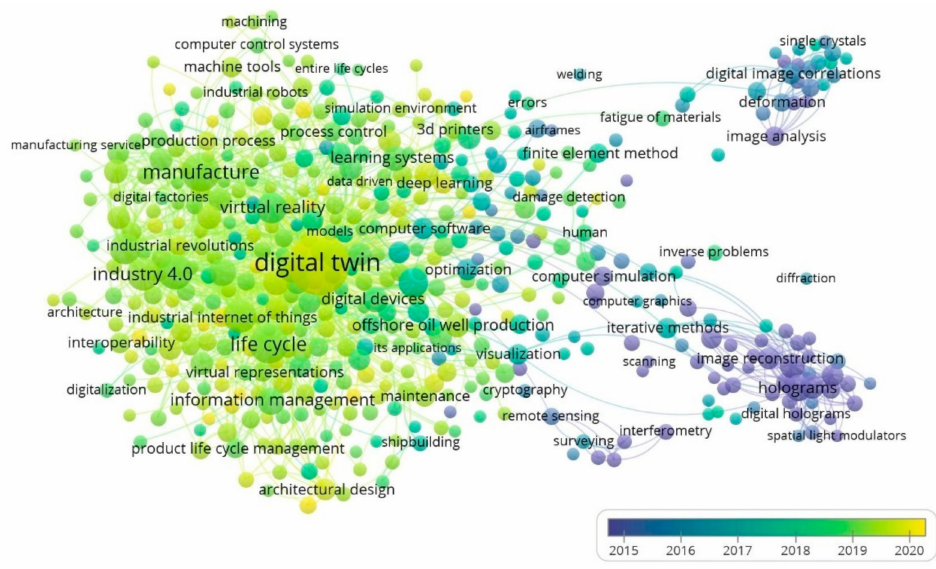
Figure 8. Overlay visualization of the DT research field. The keywords were grouped into clusters, represented by different colors. In particular, the keywords were clustered into seven groups, and each keyword was assigned to only one cluster. As shown by the network visualization (Figure 7), the DT research field is primarily composed of seven clusters of connected topics: Industry 4.0 and IoT (cluster— blue), learning systems (cluster—red), smart manufacturing (cluster—green), information management (cluster—cyan), life-cycle management (cluster—purple), holograms (cluster— yellow), and digital image analysis